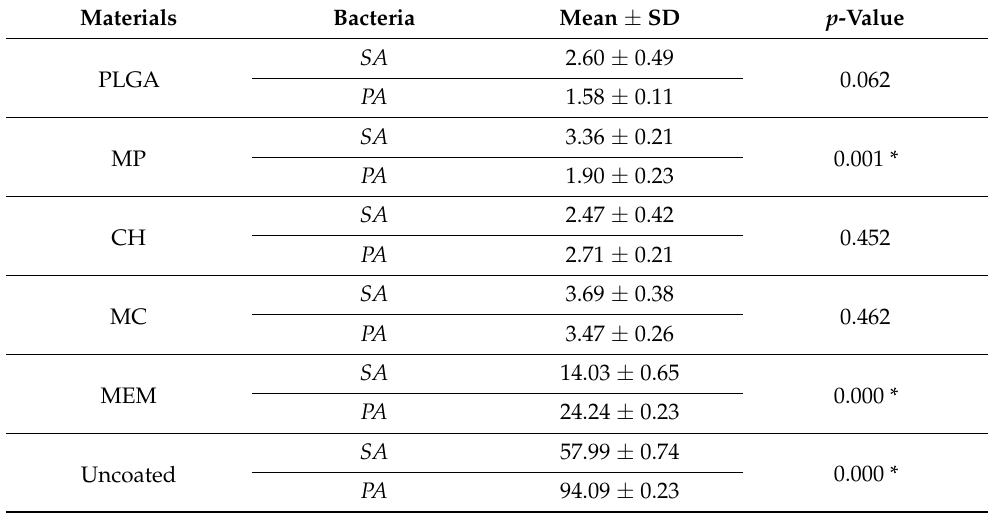
Table 3. MTT differences for SA and PA within each